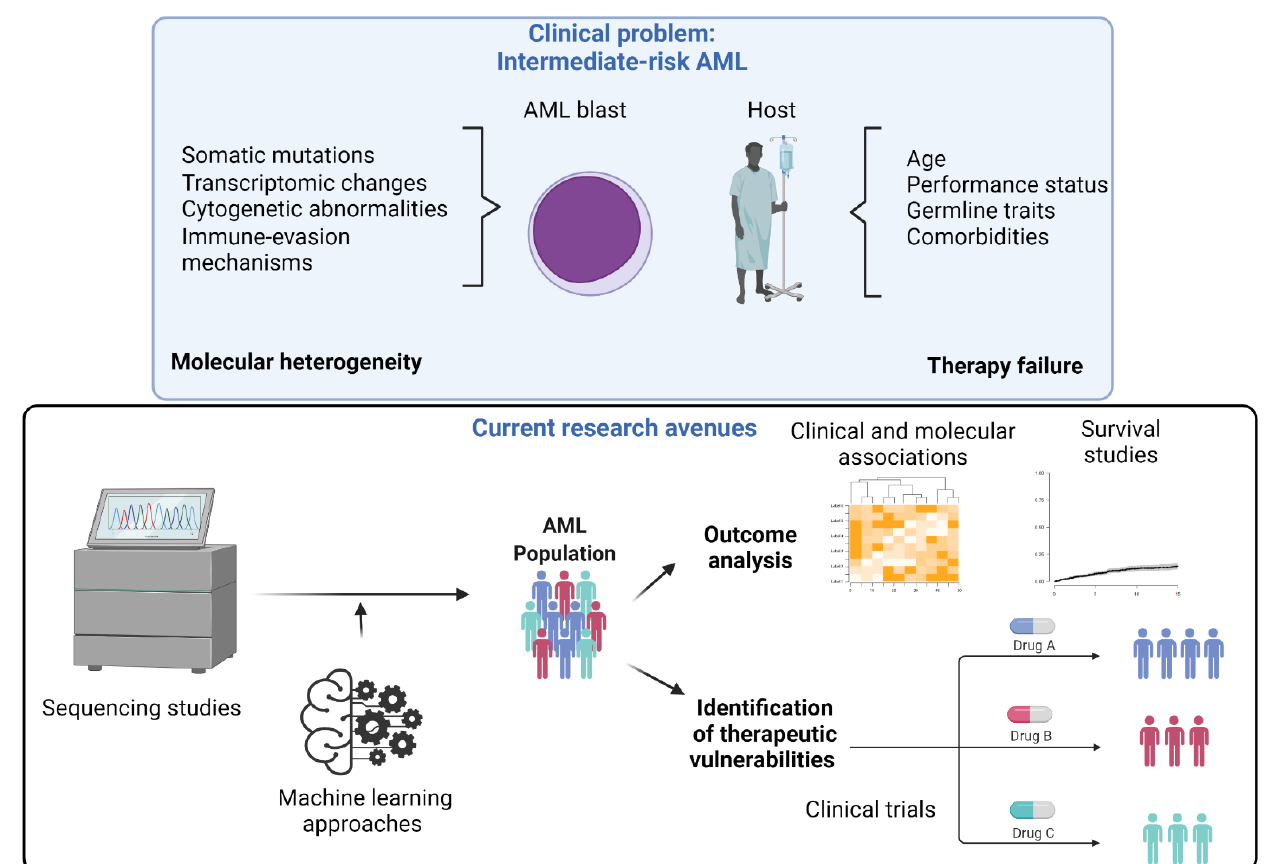
Figure 1. The clinical problem of intermediate-risk AML. The upper panel summarizes features responsible for molecular heterogeneity, and host-related outcome modifiers are summarized. In the lower panel, current research approaches to ameliorating the outcomes of such patients are illustrated. Specifically, the application of genome scanning techniques and machine learning methods may help better characterize AML populations to assess geno-phenotypic associations and identify therapeutic vulnerabilities.